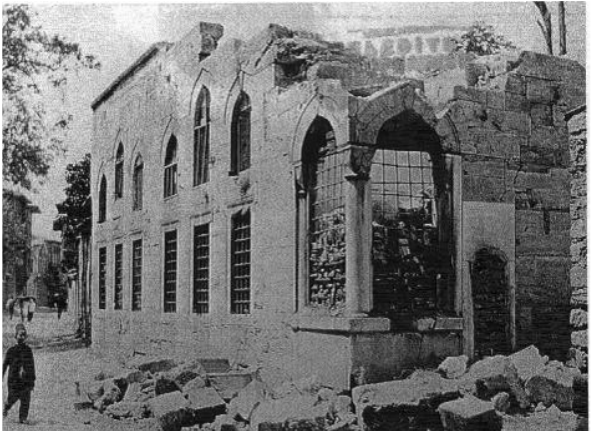
Fig. 5. Another example of damage caused by the 1894 earthquake in Istanbul (http://www.tarihimiz.net/v3/haberler/genel/